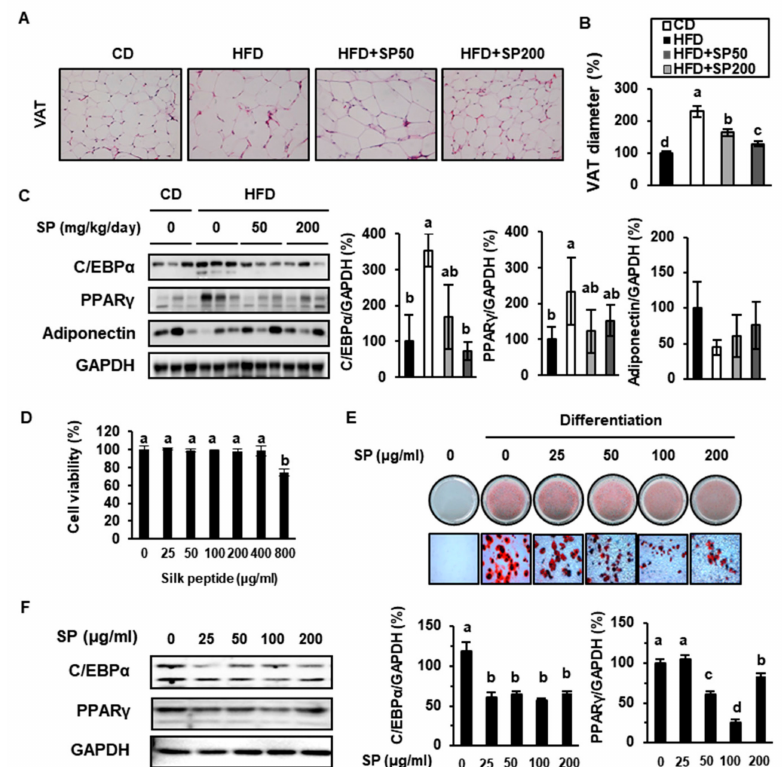
Figure 3. Effect of silk peptide on lipid accumulation in visceral adipose tissue from high-fat diet-fed mice and 3T3-L1 cells. ( A ) Hematoxylin and eosin staining of VAT from mice treated for 6 weeks. ( B ) Mean diameter of VAT cells (arbitrary units). ( C ) The expression of adipogenic factors in VAT was measured by western blotting. ( D ) Viability of 3T3-L1 pre-adipocytes treated with SP for 24 h. ( E ) Oil red O was used to stain cells after 10 days of differentiation in the presence or absence of SP, and photomicrographs were obtained (400 × magnification). ( F ) Expression levels of proteins involved in adipogenesis in 3T3-L1s. Data are the mean ± SD of six replicates and were analyzed using one-way ANOVA and Duncan’s test. Values with different letters are significantly different; p < 0.05 (a > b > c >